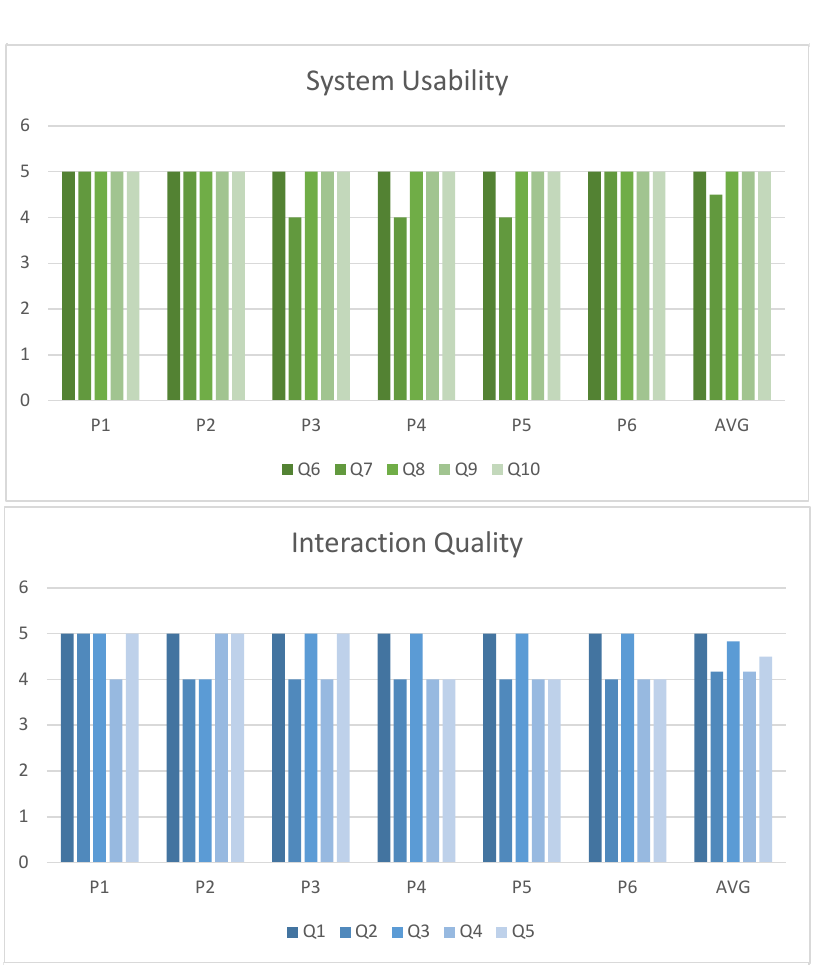
Figure 5. Results of the questionnaire for the elderly. Top: answers to the questions on general usability (first five questions). Bottom: answers to the questions on quality of interaction (second five